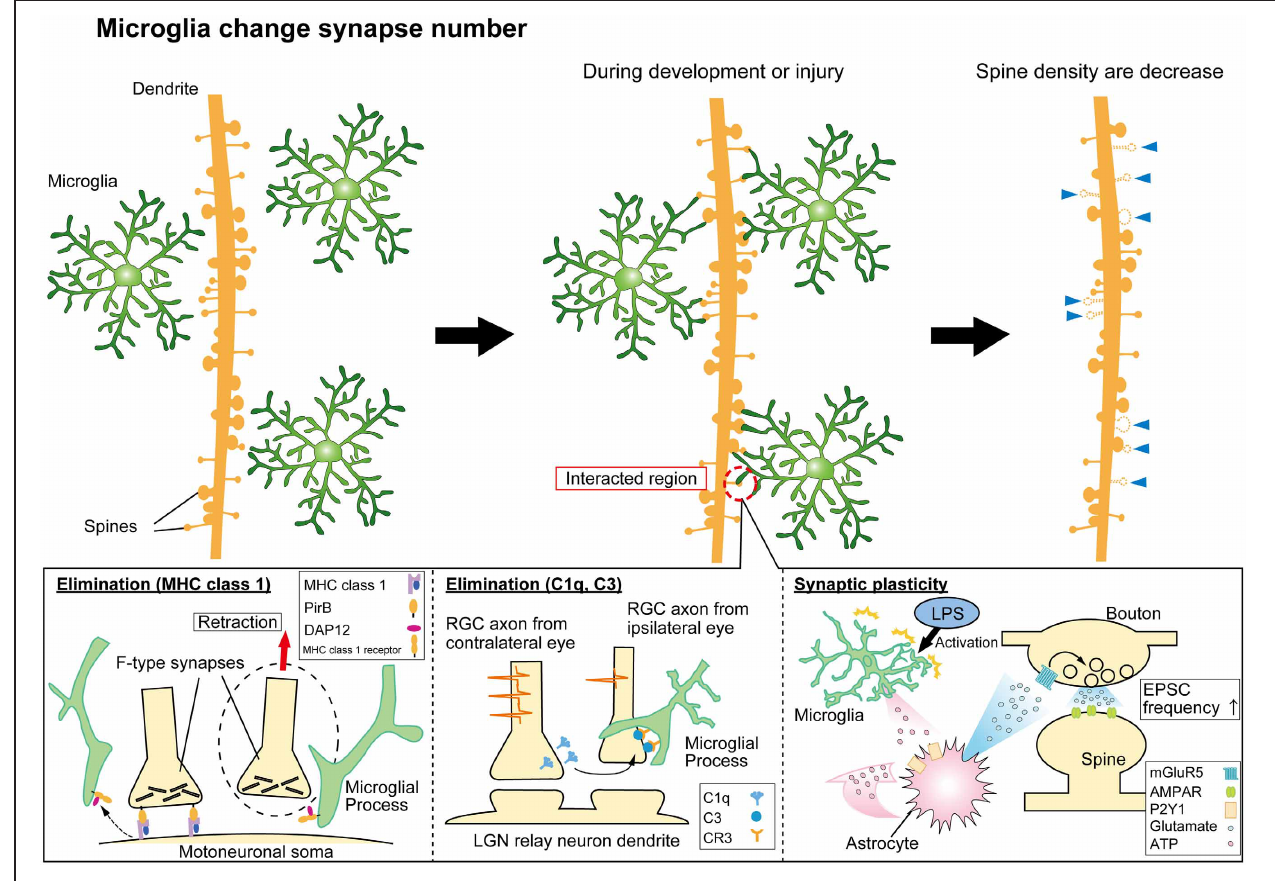
molecules such as MHC class 1 proteins ( lower left panel) and complement cascade proteins ( lower center panel) have been suggested to contribute to the phagocytosis of synapses by microglia. Activated microglia can also modify functional transmission at synapses via signaling pathways involving ATP, astrocytes, and glutamate receptors as indicated ( lower right